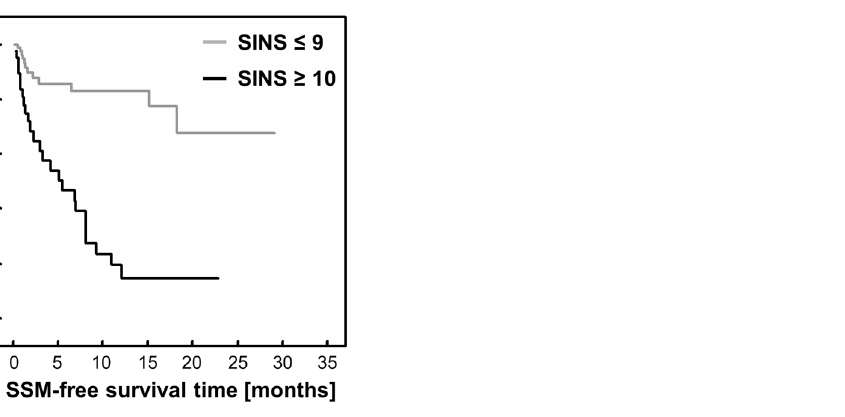
Figure 4. Kaplan–Meier SSM-free survival time curve according to the SINS ( ≥ 10 and ≤ 9). SINS: Spinal Instability Neoplastic Score; SSM: symptomatic spinal metastasis. n (SINS ≤ 9) = 88, n (SINS ≥ 10) = 40.